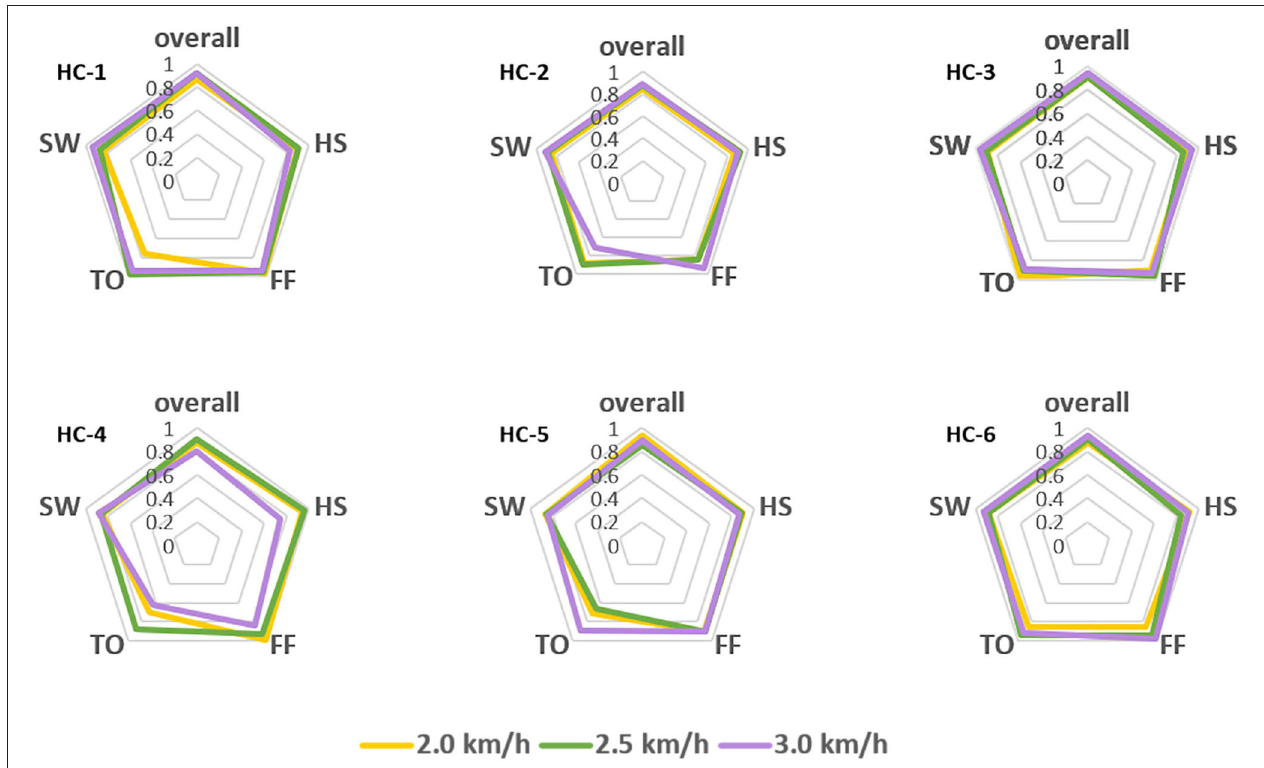
FIGURE 4 | Comparison of the gait phase decoder across three predefined speeds for the six healthy subjects. Both the overall performance and the sub gait phase decoding accuracy are in the same radar chart as different